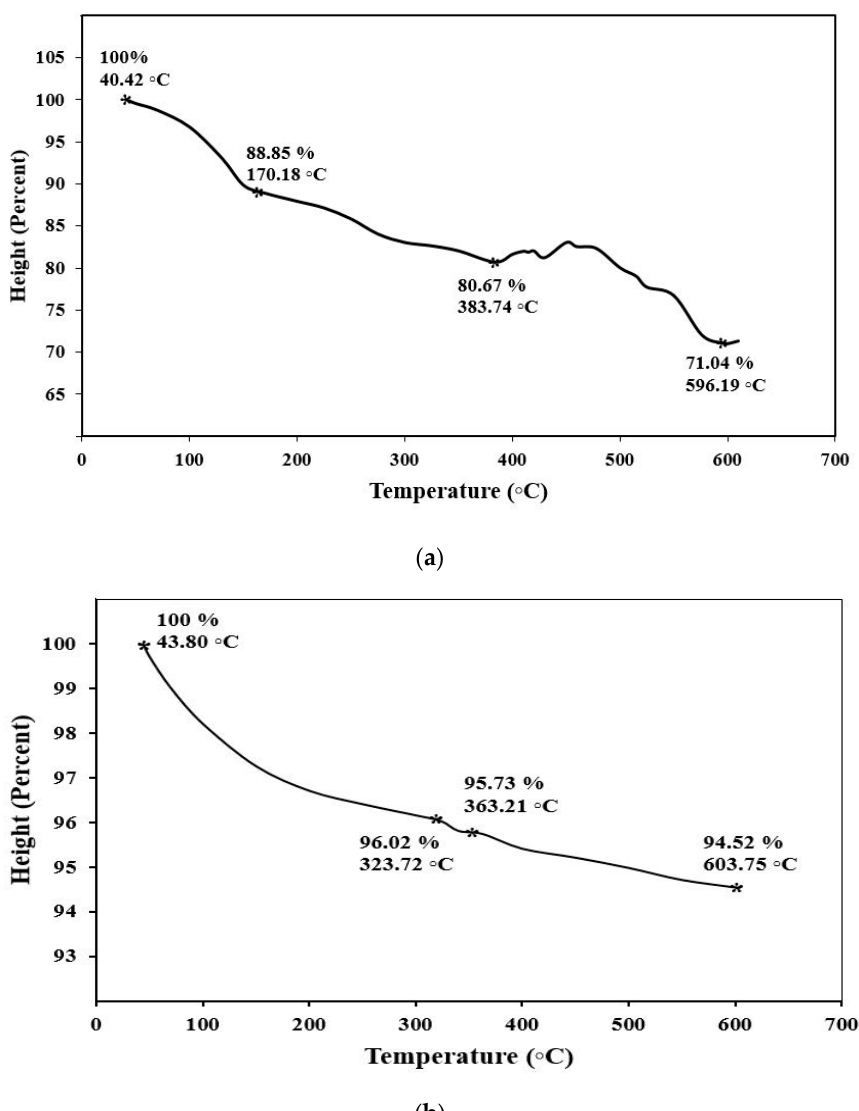
Figure 4. TGA thermograms of polycarbazole prepared in ( a ) the absence and ( b ) presence of an electrical field.